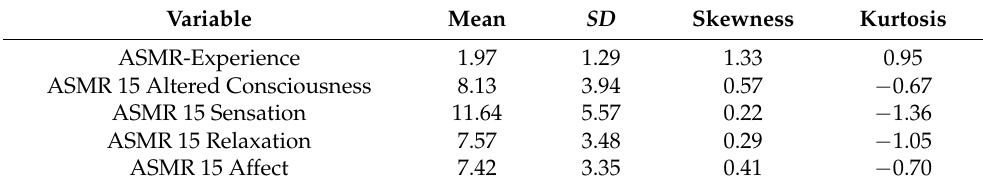
Table 4. Descriptive statistics of the ASMR variables (ASMR-Experience and ASMR 15 dimensions).